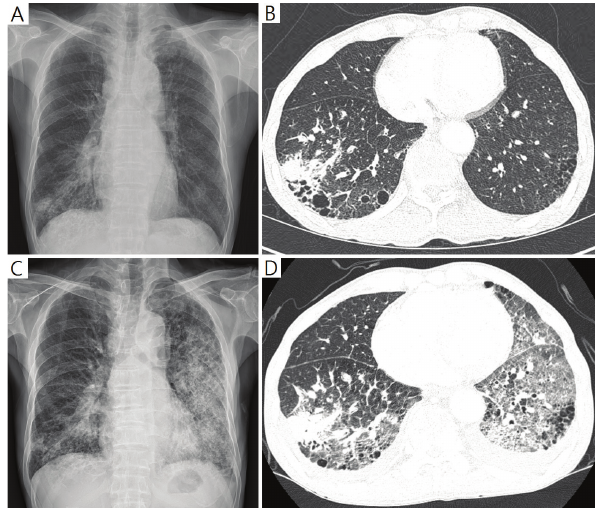
Figure 1: Newly developed diffuse ground glass opacities and con- solidation in both lung fields on chest X-ray and chest CT scan at the admission (A, B) and the 7th day after (C, D).